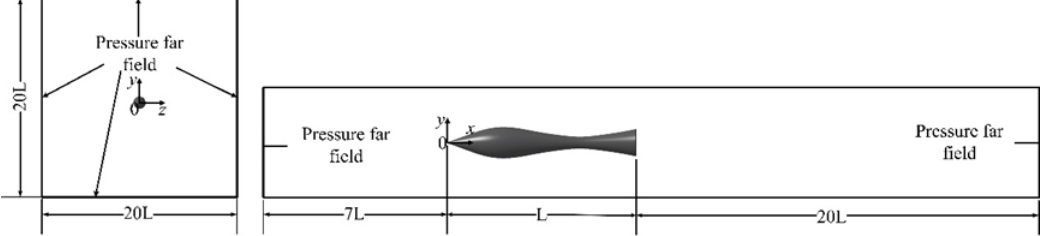
Figure 3. Two-dimensional diagram and boundary setting of the computational domain for the waisted body.